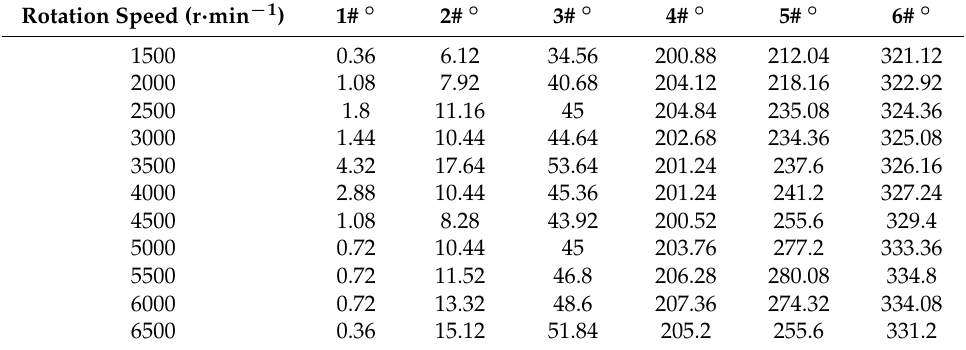
Table 3. The angle of split points for the six phases under different rotating speeds.